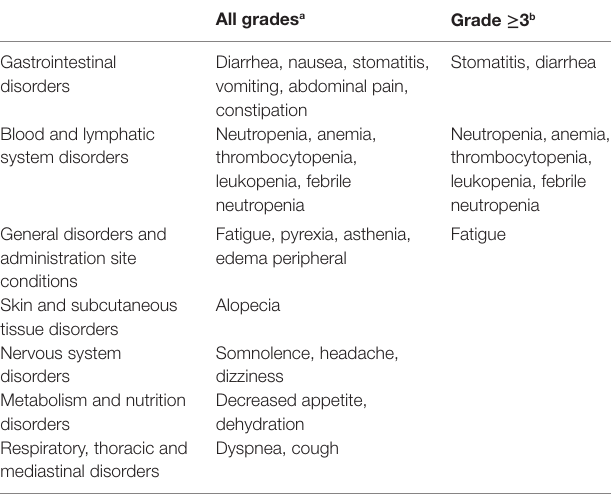
TABLe 1 | Most common treatment-emergent adverse events of alisertib dosed at 50 mg orally twice daily for 7 days followed by 14 days of